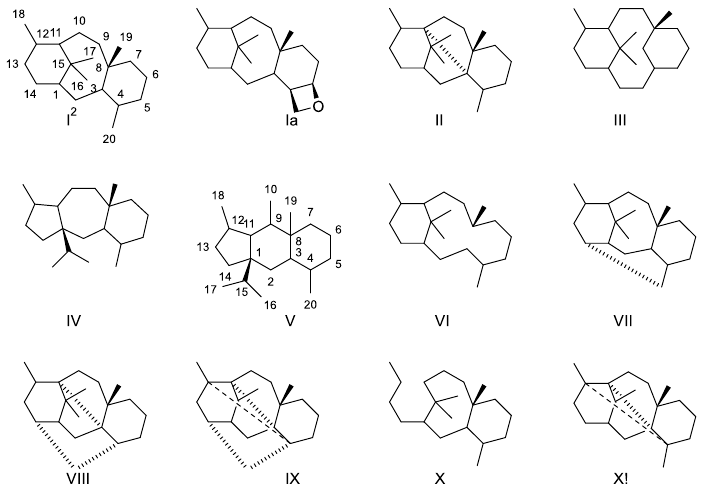
Figure 2. Skeletons found in diterpenes isolated from species belonging to Taxus [14]. In a nomenclature system, only group I (and Ia) possessing three rings (6/8/6) is named taxanes, group II (6/5/5/6) is the 3,11-cyclotaxane, group III (6/10/6)2(3-20)abotaxane, group IV (5/7/6) 11(15-1)abotaxane, group V 5/6/6 (11(15-1),11(10-9)diabotaxane, group VI 6/12 (3,8)secotaxane, group VII 6,8,6,6 (14-20)cyclotaxane, group VIII 6/5/5/6 (3,11:12,20)dicyclotaxane, group IX 5/5/4/6/6/6 (3,11:4,12:14,20)tricyclotaxane, group X 8/6 (11,12)secotaxane and group XI 6/5/5/4/6